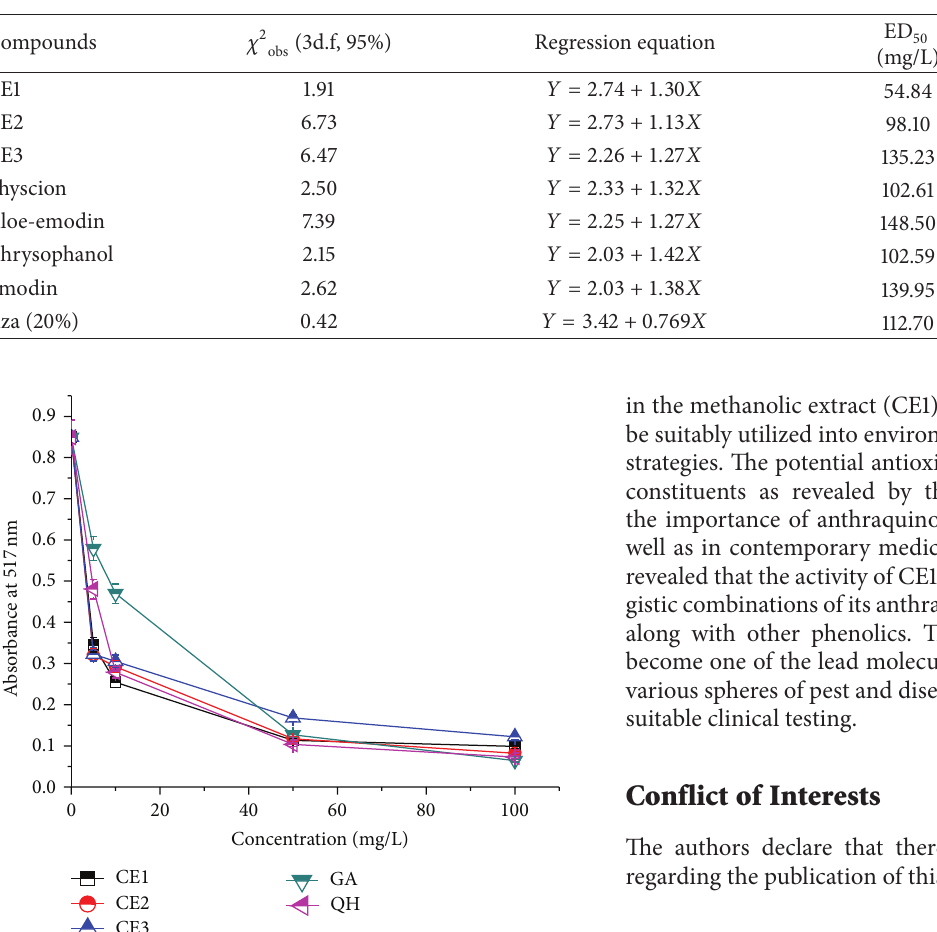
) of isolated anthraquinones and solvent extractives of Rheum emodi against j 50